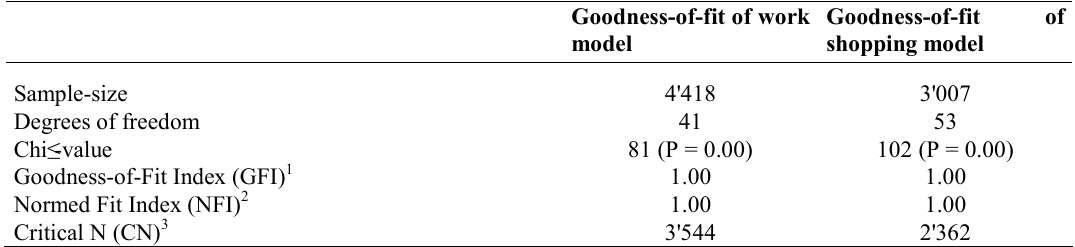
Table 6. Goodness-of-fit of the two modified models